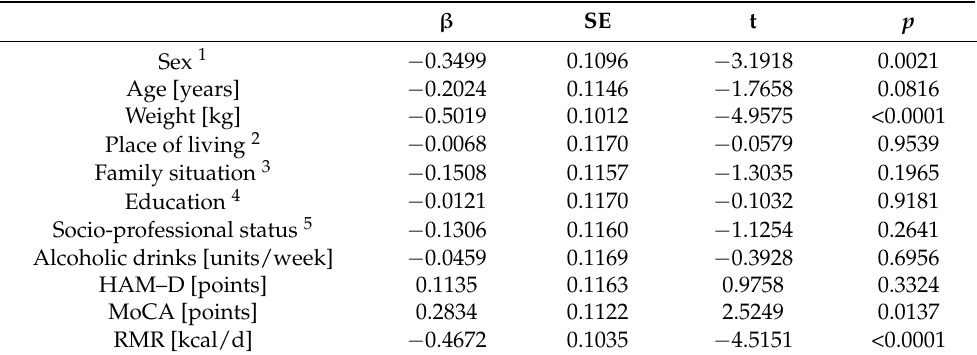
Table 10. Univariate linear regression analysis assessing the relationship between total physical activ- ity [counts/minute] measured by the ActiGraph and selected variables in the total study population ( n = 75).